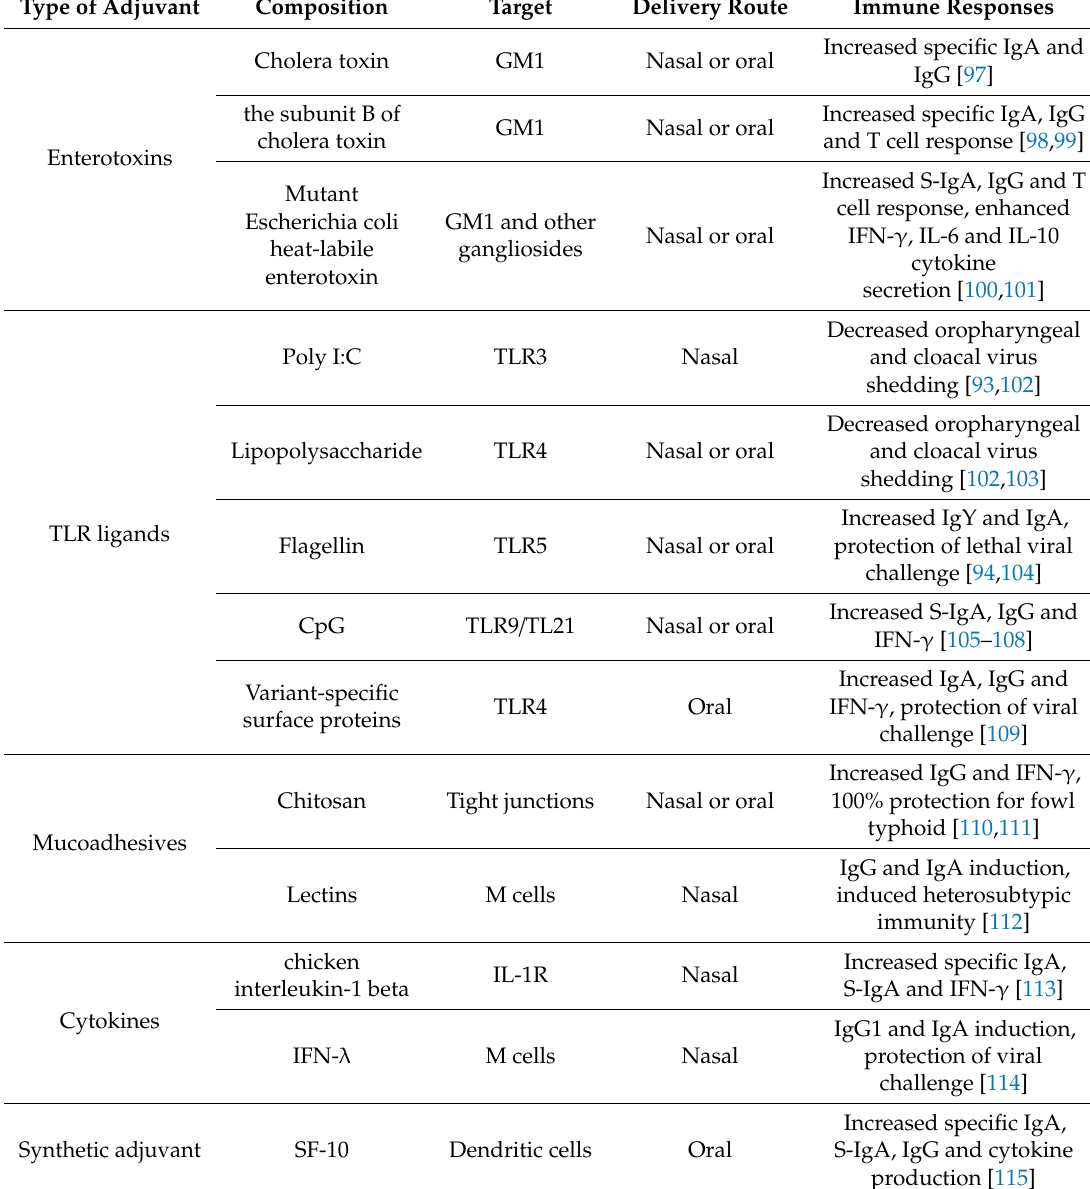
Table 1. Representative nasally or orally administered vaccine adjuvants and immune